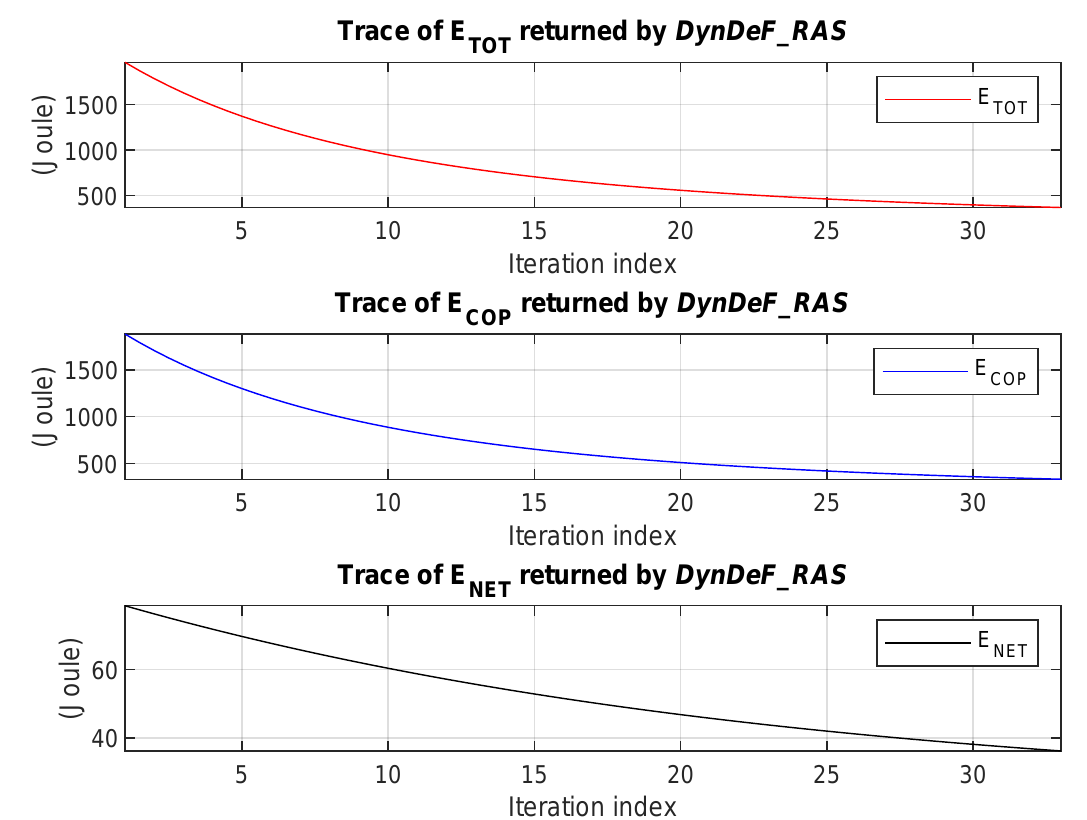
Figure 13. Traces under topology T 1 of the: ( top ) total energy E TOT ; ( middle ) computing energy E COP ; and ( bottom ) network energy E NET returned by the DynDeF_RAS .